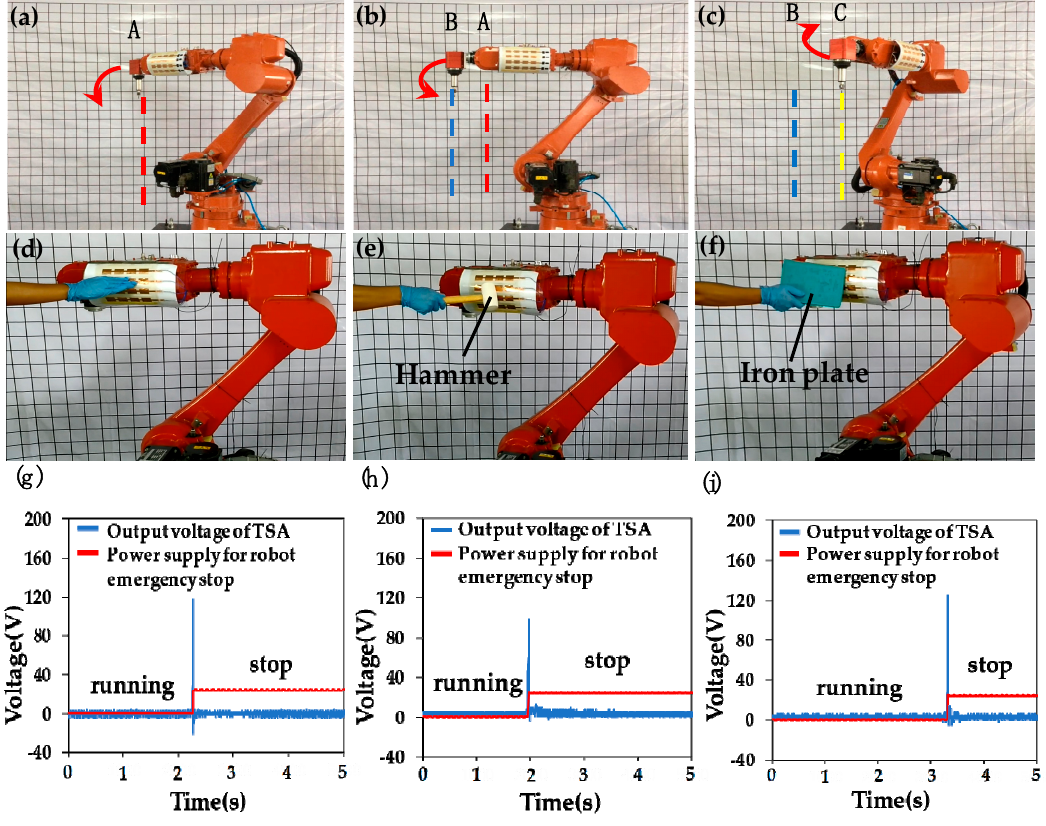
Figure 4. Experimental results of the tactile feedback system for application of robot obstacle avoidance; ( a – c ) The movement of the forearm without interruption; ( d – f ) Obstacles like hand, hammer and metal plate applied on the TSA during the movement of the forearm; ( g – i ) Real-time performance of the tactile feedback system.